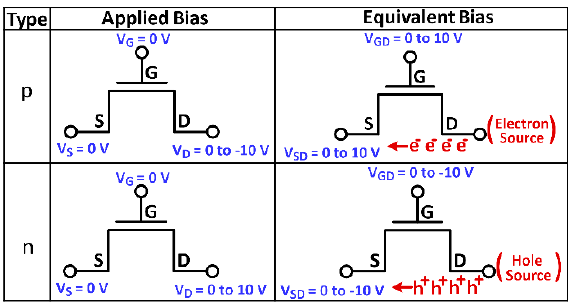
ff ect of bias in the ambipolar MAPbI Figure 7. Effect of bias in the ambipolar MAPbI 3 TFTs. Figure 7. E